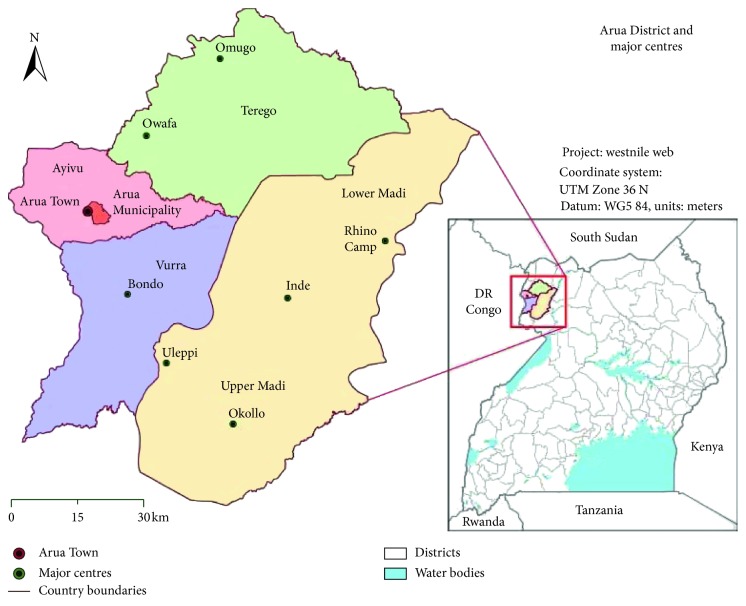
Adopted from https://www.google.com/url?sa=i&source=images&cd=&cad=rja&uact=8&ved=2ahUKEwizi9Hz67feAhXMyYUKHfSACcQjRx6BAgBEAU&url=https%3A%2F%2Fbmcpublichealth.biomedcentral.com%2Farticles%2F10.1186%2Fs12889-017-4589-9&psig=AOvVaw2Hk7L_5ZwKBVO_sm6o1aGP&ust=1541321421556437 (accessed on November 2, 2018).